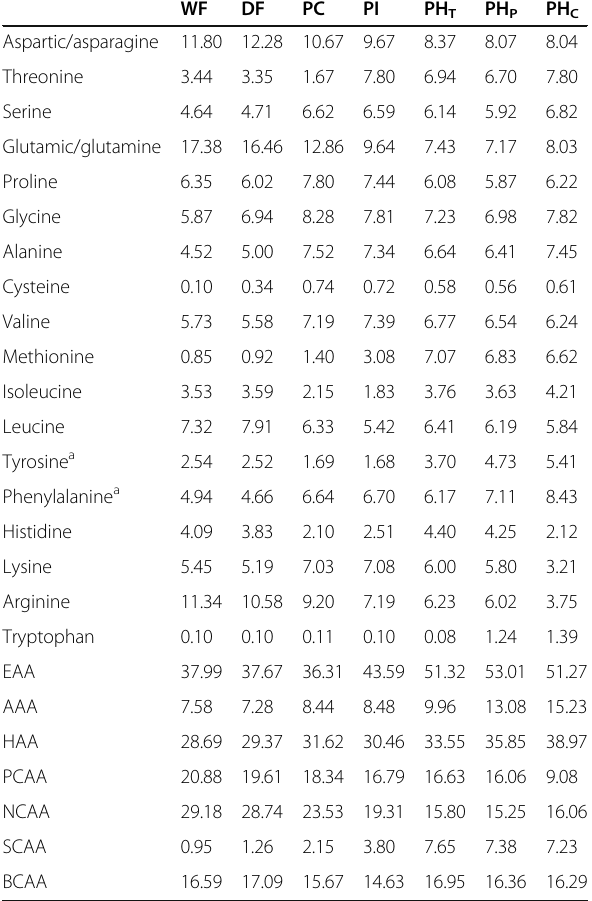
Table 2 Amino acid profiles of okra seed samples